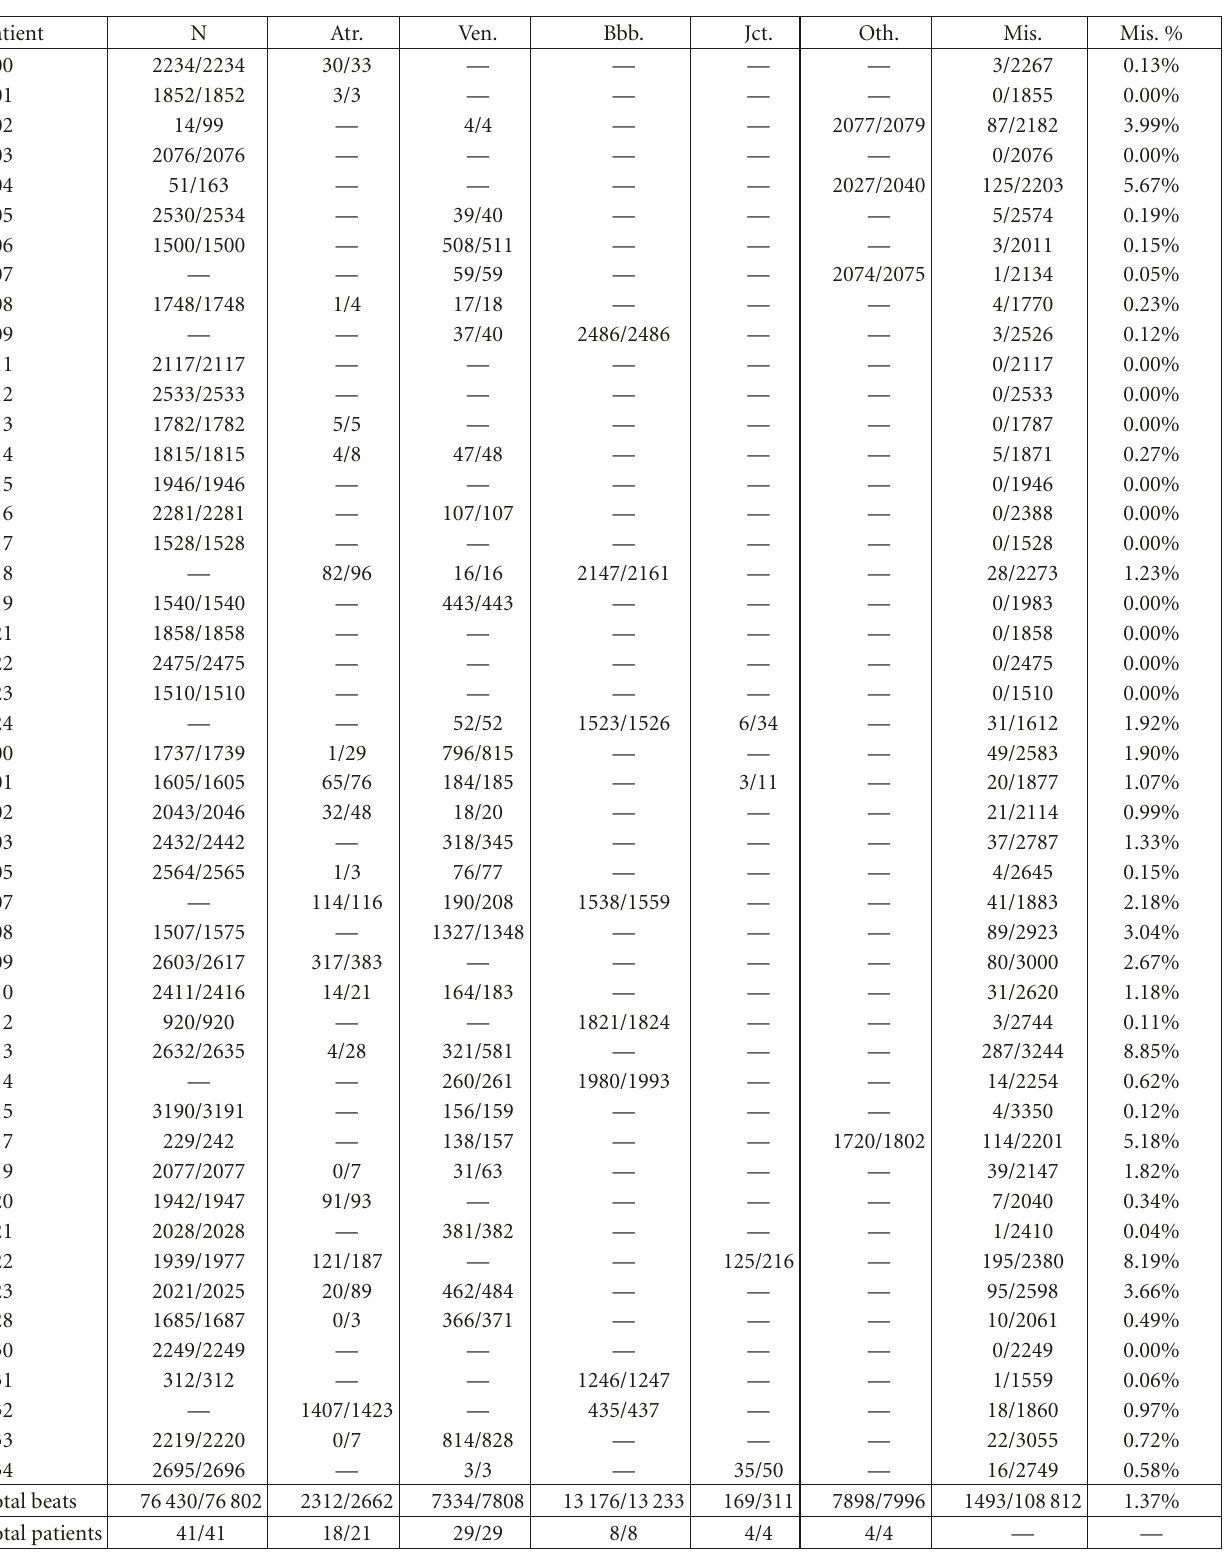
Table 1: Beats detected for each patient in the MIT-BIT Arrhythmia database using symbolization. To compactly display results we group the clinical classes (N = normal, Atr. = atrial arrhythmias, Ven. = ventricular, Bbb. = bundle branch block, Jct. = junctional beats, Oth. = others, Mis. = mislabeled beat). For each group, the number of correctly detected beats is shown relative to the total beats originally present. The aggregate detection performance is given in terms of both beats (i.e., total number of beats for each group correctly detected across population) and patients (i.e., total number of patients for whom the group of activity was correctly detected to